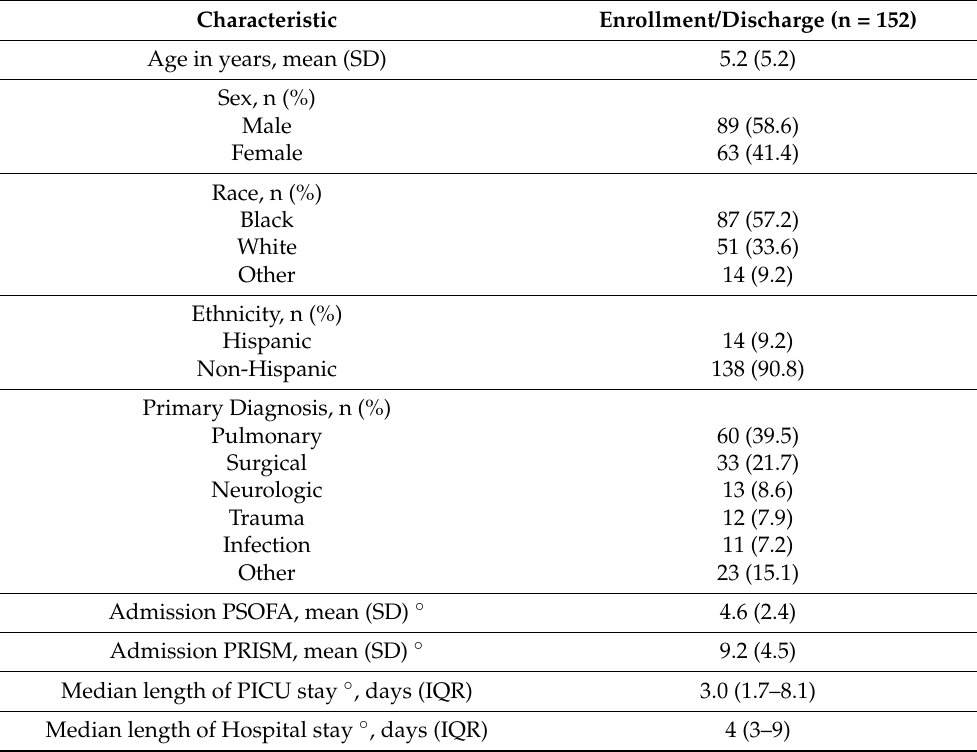
Table 1. Demographic and clinical characteristics of study